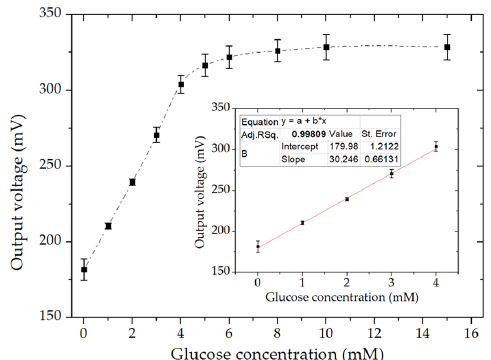
Figure 7. Dependence of the output voltage on glucose concentration for the EBFC based on the GOx-modified bioanode and laccase-modified biocathode under optimized conditions. The output voltage was continuously monitored at an applied current density of 100 µA∙cm −2 with the addition of each glucose concentration. The results are shown as the average of the measurements from three devices (mean ± S.D.). Inset: Linear part of the calibration graph.